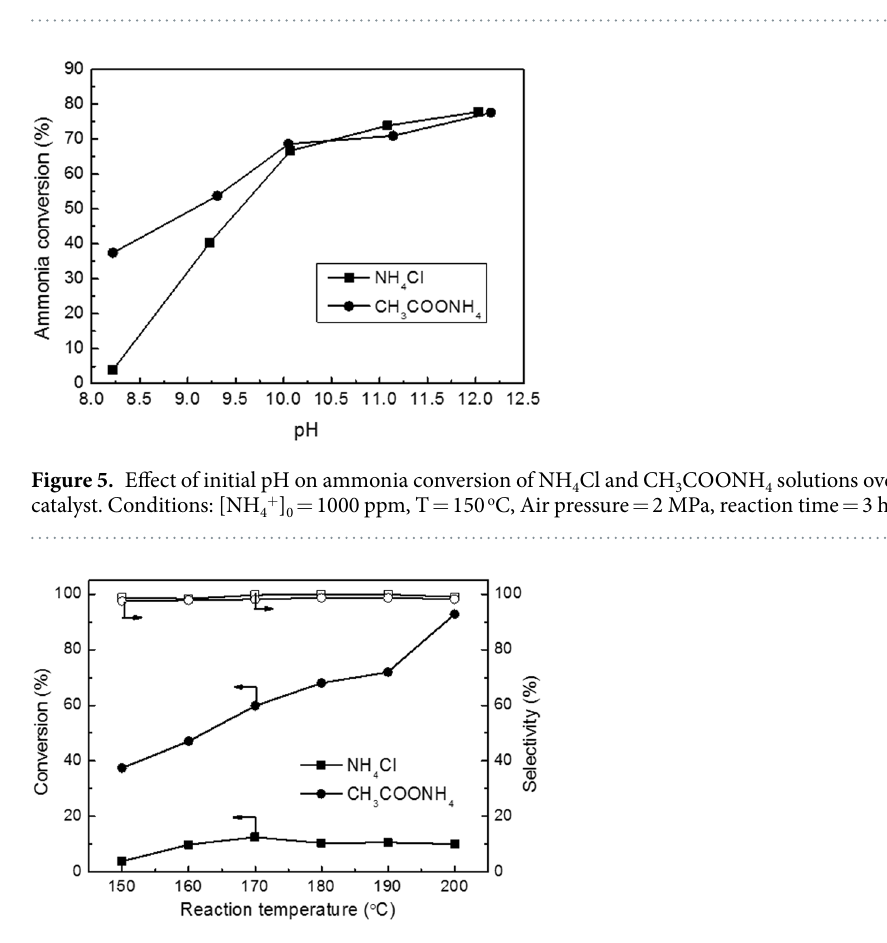
Table 2. Effect of different anions on the ammonia conversion for CWAO of ammonia to N 2 over Ru-Cu/C catalyst. Conditions: [NH